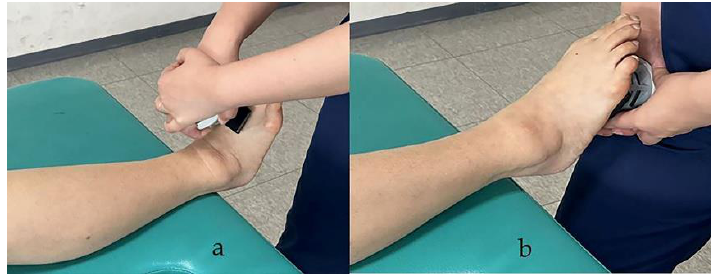
Figure 1. Measurement of muscle strength in tibialis anterior ( a ) and gastrocnemius ( b ).